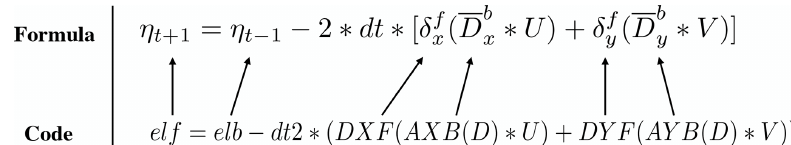
Figure 6. The effect of “the self-documenting code is the formula” illustrated by the sea surface elevation